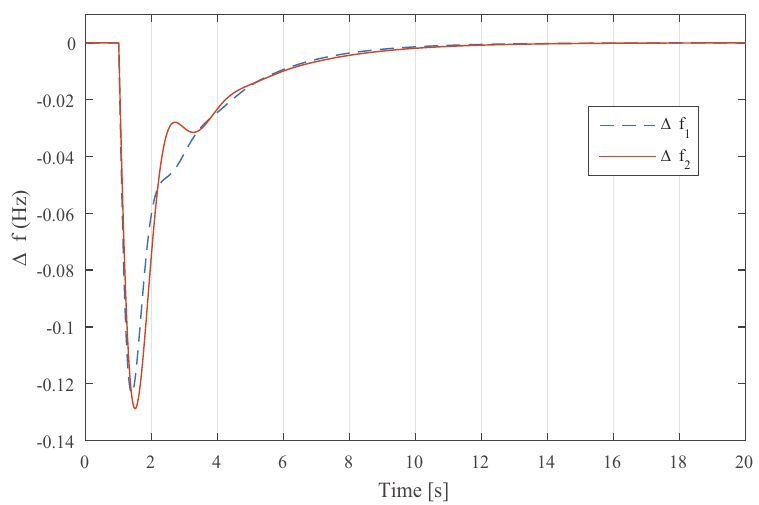
Figure 3. Responding curves of V2G system without SOC.